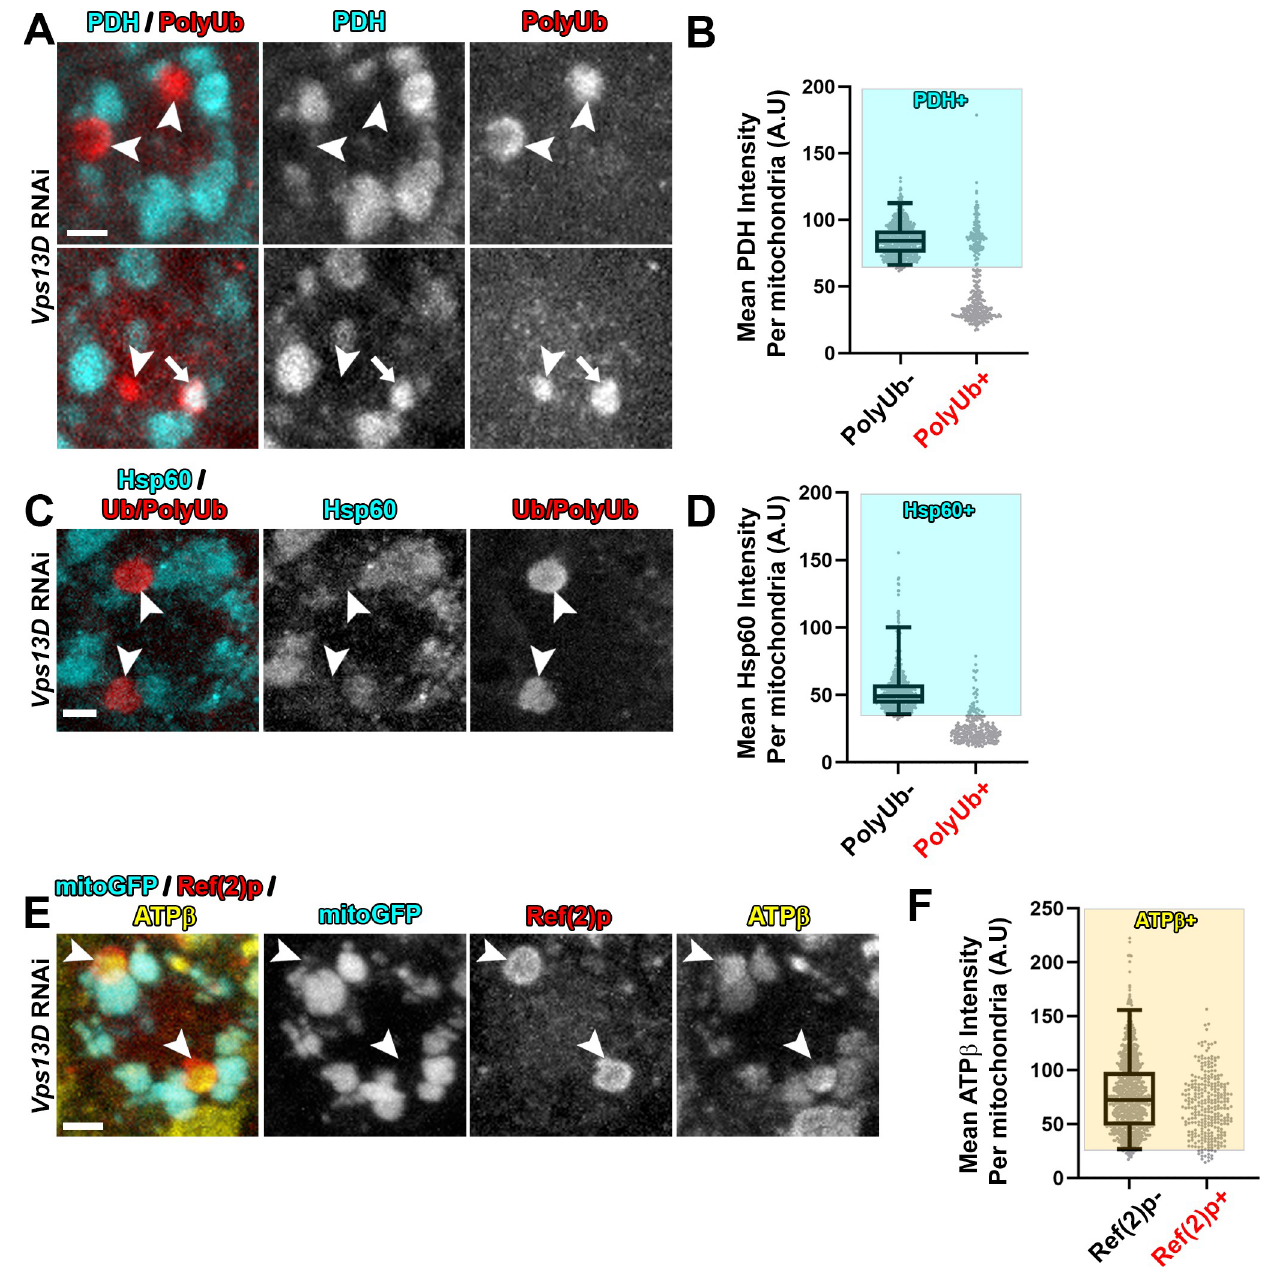
Fig 2. Mitophagy intermediates in Vps13D depleted neurons lack endogenous soluble matrix proteins, but contain endogenous IMM protein. Representative images of single motoneuron cell bodies which express Vps13D RNAi via the D42-Gal4 driver. A,C) VNC tissue was stained for stained for endogenous mitochondrial matrix proteins pyruvate dehydrogenase E1 α (PDH) (A) or Hsp60 (C) (cyan) and PolyUb or Ub/PolyUb (red). Arrowheads highlight examples of PolyUb+ objects lacking matrix staining, while the arrow highlights an example of a PolyUb+ object that contains PDH. Scale bars = 2 μ m. B,D) Distribution of mean intensities for PDH (B) and Hsp60 (D) from mitochondria in motoneurons. The right columns show objects selected based on positivity for PolyUb (n = 351 PolyUb+ objects from 5 larval VNCs for (B) and n = 227 PolyUb+ objects from 5 larval VNCs in (D)). The left columns show the population of conventional (PolyUb-) mitochondria (n = 789 mitochondria from 5 larval VNCs for (B); n = 744 mitochondria from 5 larval VNCs for (D)). Based on the criteria of intensity greater than 2.5% of conventional mitochondria (shading), 33.6% of the PolyUb+ objects contain PDH, while 13.7% contain Hsp60. E) VNC tissue was stained for endogenous mitochondrial IMM protein ATP β (yellow) and Ref(2)p (red). Arrowheads highlight examples of Ref(2)p+ objects that lack mitoGFP but contain ATP β . Scale bar = 2 μ m. F) Distribution of mean intensities for ATP β from mitochondria in motoneurons. The right column shows objects selected based on positivity for PolyUb (n = 296 PolyUb+ objects from 5 larval VNCs). The left column shows the population of conventional (PolyUb-) mitochondria (PolyUb-) (n = 883 mitochondria from 5 larval VNCs). Based on the criteria of intensity greater than 2.5% of conventional mitochondria (shading), 94.3% of the PolyUb+ objects contain ATP β .